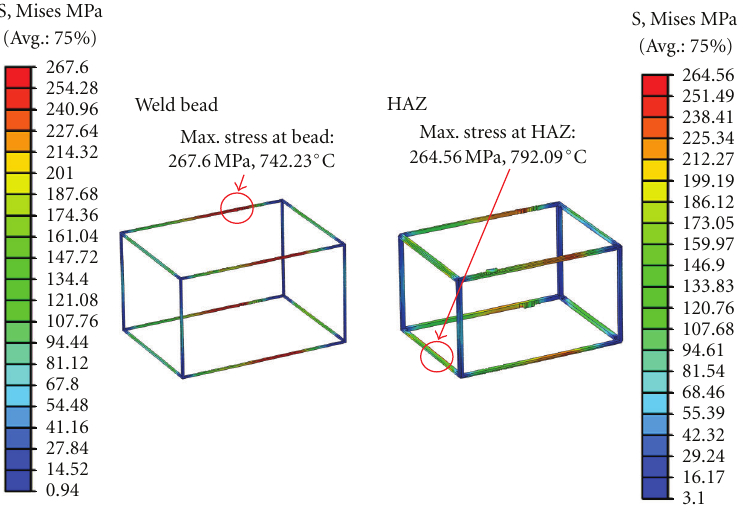
Figure 18: Stress contours of a 10kW class PHE prototype in weld zone from an elastic-plastic analysis using the weld material